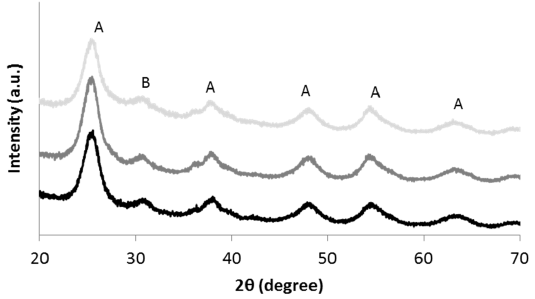
Figure 2. XRD diffractograms of TAC (light gray), TACF (medium gray) and TACR (black); (A = anatase; B = brookite).